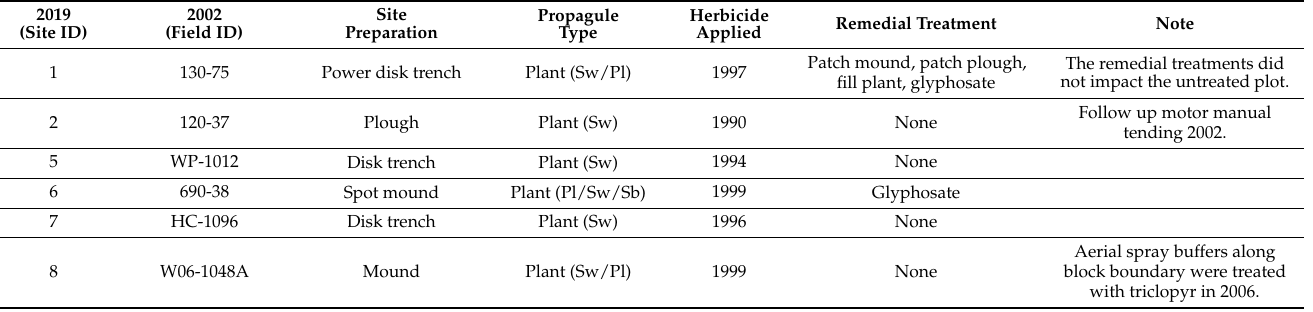
Table 1. Study sites included in the 2019 and 2002 assessments. Sites in which a significant portion of the untreated area was disturbed were excluded from the 2019 assessment (“NA”). Sw = white spruce ( Picea glauca (Moench) Voss) and Pl = lodgepole pine ( Pinus contorta Dougl. ex Loud. var. latifolia